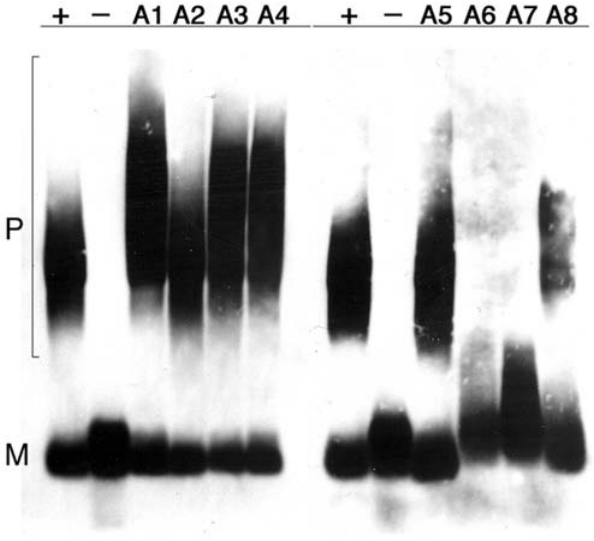
Figure 7. SDD-AGE analysis of Sup35p polymers in G402 [ PSI + ] cells. After inducing expression of Sup35-GFP fusion protein (NGMC) for 15 hours, log phase cells were harvested and cell lysates were incubated in SDS to dissolve all but the prion polymers. The lysates were then separated on agarose gels and immunoblotted using anti- GFP antibodies. Strain names are indicated at top. Horizontal line at top indicates origin. A1-A4 were processed separately from A5-A8. Wild type 779-6A [ PSI + ] and [ psi 2 ] controls processed independently for each blot show consistency between the blots. The high molecular weight smear represents polymers (P) of NGMC, faster migrating NGMC monomer (M) is at the lower part of the blot.